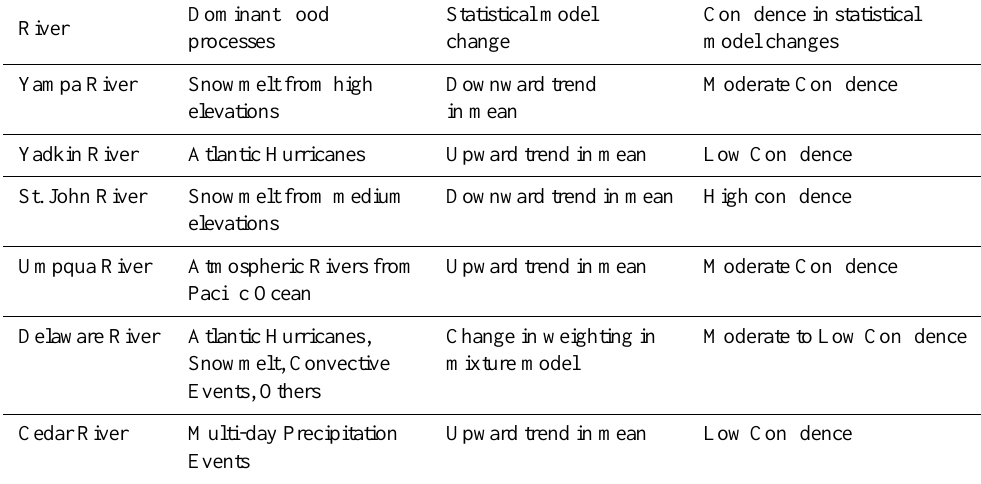
Table 3. Illustration of a teaching exercise that draws connections between a river, dominant flood processes, changes in statistical models due to non-stationary climate drivers, and the confidence in the suitability of the change to the statistical